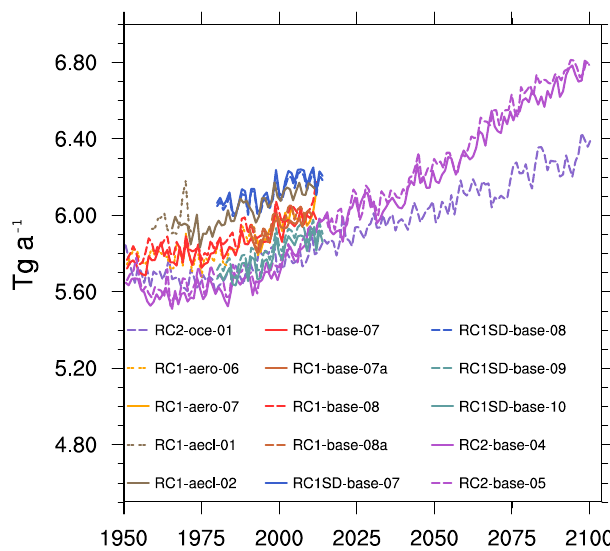
Figure 3. Annual total emissions of on-line calculated biogenic iso- prene emissions in Tg ( C ) a − 1